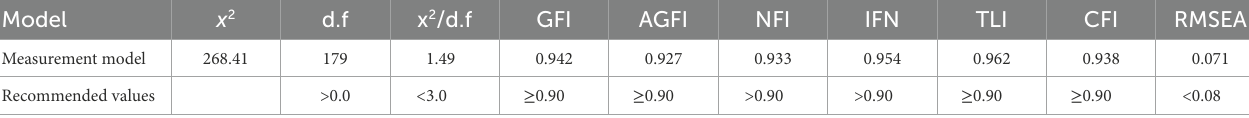
TABLE 5 Model fit indices.